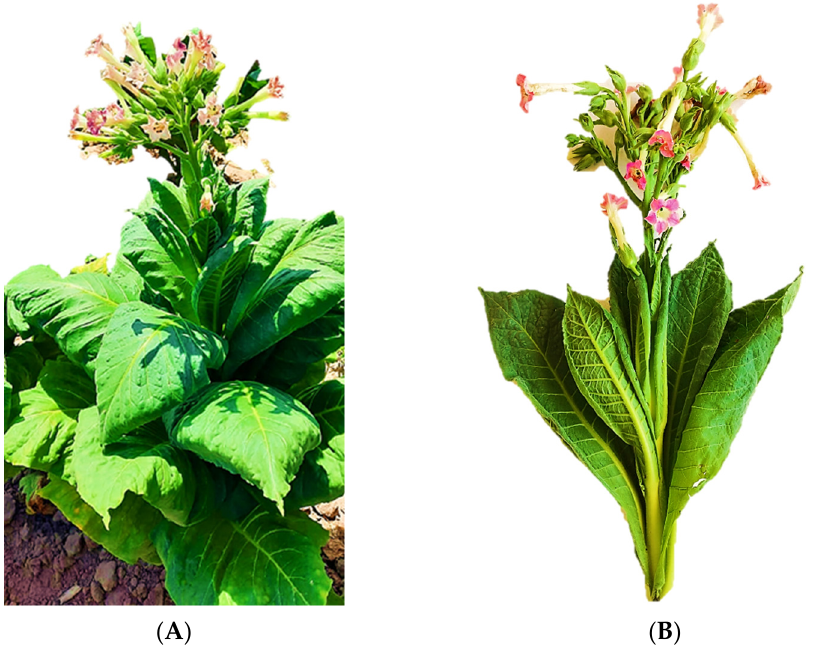
Figure 1. Nicotiana tabacum var. Virginia. ( A ) Plant with flowers prior to the blunt at the field. ( B ) General aspect of pre-harvest waste collected during the blunt (flowers and apical leaves).